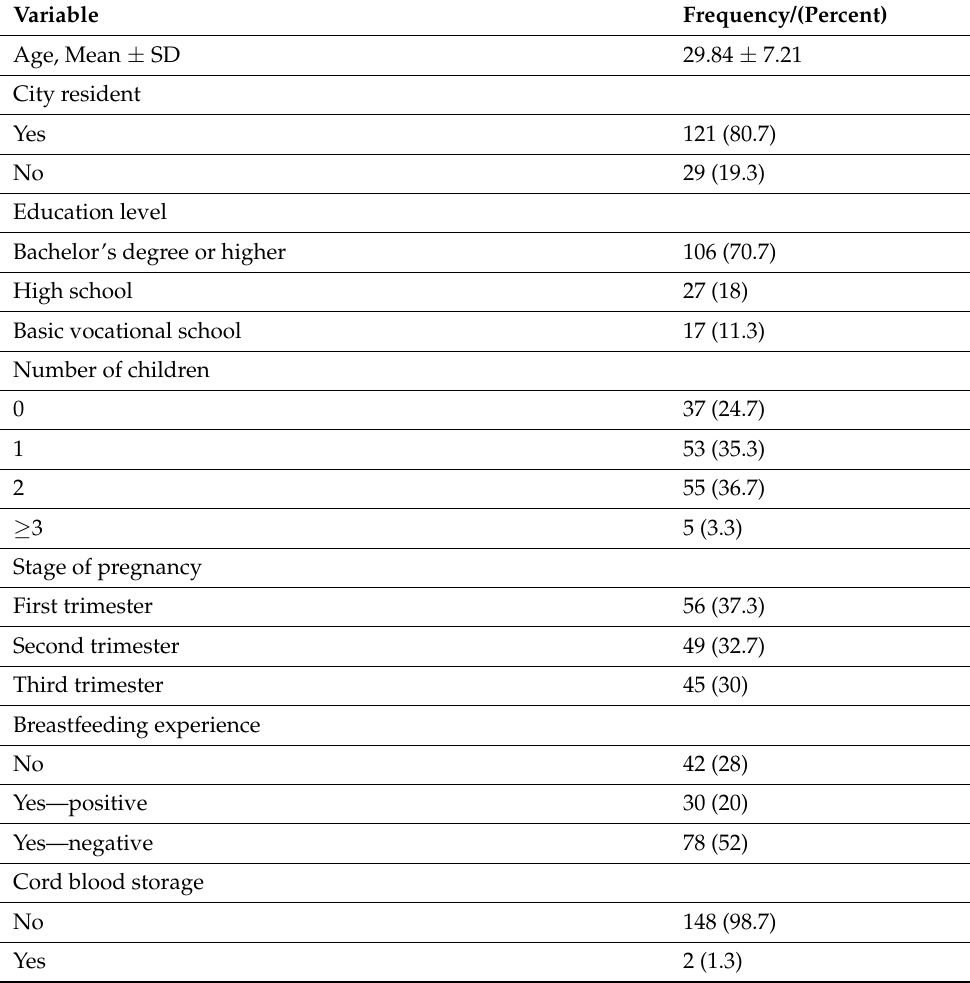
Table 1. Socio-demographic and obstetric characteristics of pregnant women responding to the survey about stem cells (n =